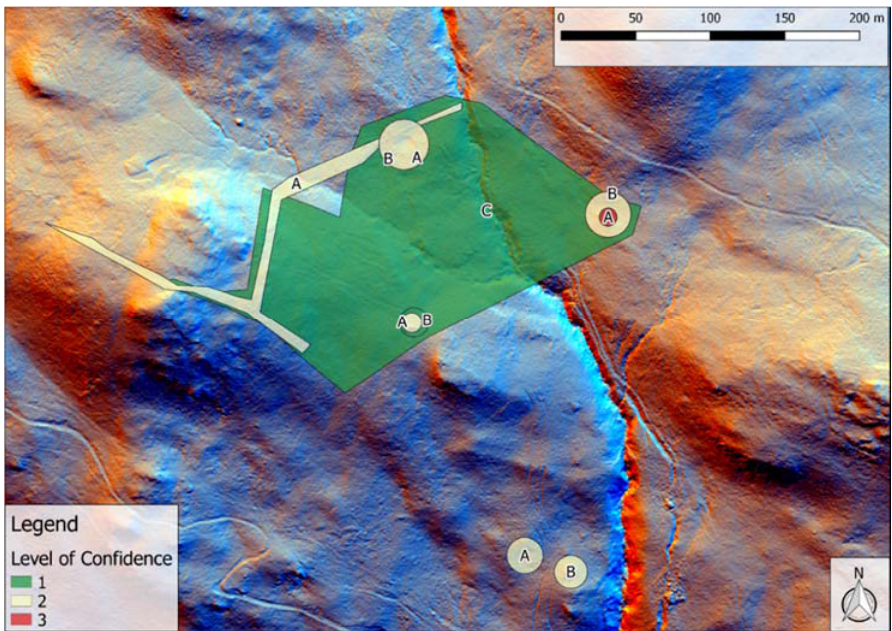
Figure 7. An example of the results of desk ‐ based interpretation of ALS derivatives (1–the highest level of confidence) superimposed over a multi ‐ direction hill ‐ shade visualisation. Note the differences between the outputs from three different interpreters (A, B, C). While some archaeological features were identified by a single person, others were recognized by many. In the latter case, a single monument might be dealt with differently by different interpreters including: (a) with a varied level of confidence; (b) with a variable extent; (c) by including nearby features and thus creating large polygons or by drawing multiple smaller outlines; and (d), in some cases where the same archaeological feature was identified with a similar extent by two or more observers, with different classifications. Thus, a hut circle, as interpreted by one person, could be a shieling according to another. Additionally, while some interpreters used a detailed description, others described the same features using more general terms. This provides an insight into the variability across different operators in interpreting the same datasets. © Historic Environment Scotland.